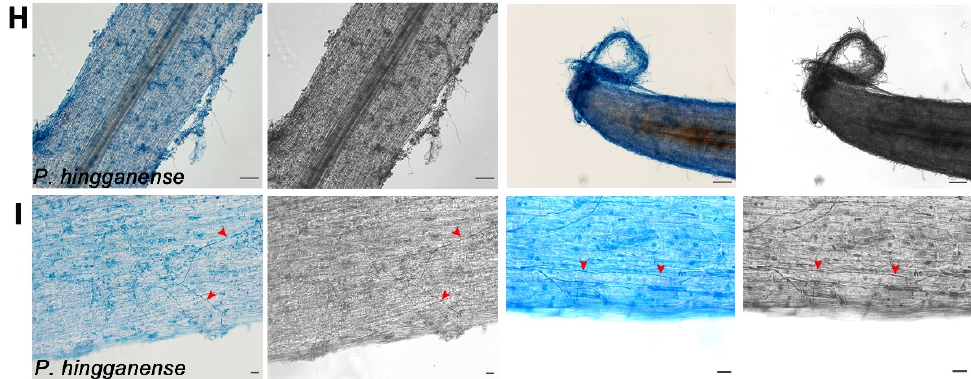
Figure 3. Colonization of P. hingganense on the roots of mung bean plants. ( A – F ) Fluorescence microscope images showing that the hyphae of green fluorescence protein (GFP)-tagged P. hingganense surrounded the roots and developed between the adjacent cells at 19 dpi. ( A ) Root of a non-treated plant. Bars, 100 µ m. ( B ) GFP-tagged P. hingganense -treated root. Bars, 100 µ m. Red arrow heads, hyphae. ( C ) Hyphae developed on the surface of the root. Bars, 20 µ m. Yellow rectangles indicate root areas that are enlarged. ( D ) Enlargement of the rectangle in ( C ). Bars, 20 µ m. Red arrow heads, hyphae. ( E ) Hypha located between the adjacent cells. Bars, 20 µ m. Yellow rectangles indicate root areas that are enlarged. ( F ) Enlargement of the rectangle in ( E ). Bars, 20 µ m. ( G – I ) Light microscope images of trypan blue staining demonstrating hyphae of P. hingganense was colonized on the surface of the root and between the adjacent cells. ( G ) Root of the non-treated plant. Bars, 100 µ m. ( H ) P. hingganense -treated root. Bars, 100 µ m. ( I ) Hyphae on the surface (left) and between the cells (right). Bars, 20 µ m. Red arrow heads,